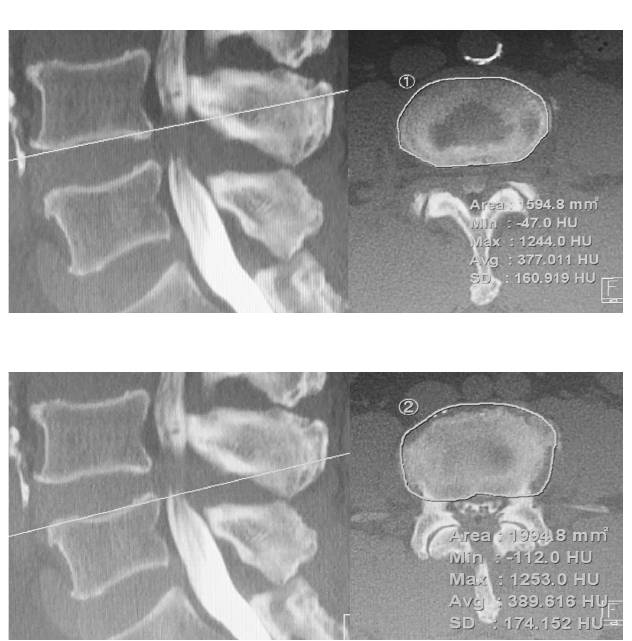
Figure 2. Computed tomography (CT) scans illustrate the method of determining the Hounsfield unit (HU) value with the use of an elliptical region of interest unit (HU) value with the use of an elliptical region of interest function.